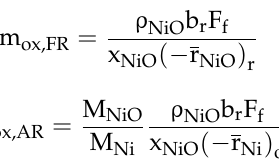
Table 3. Ni40Al-FG Oxygen carrier characteristics [24].